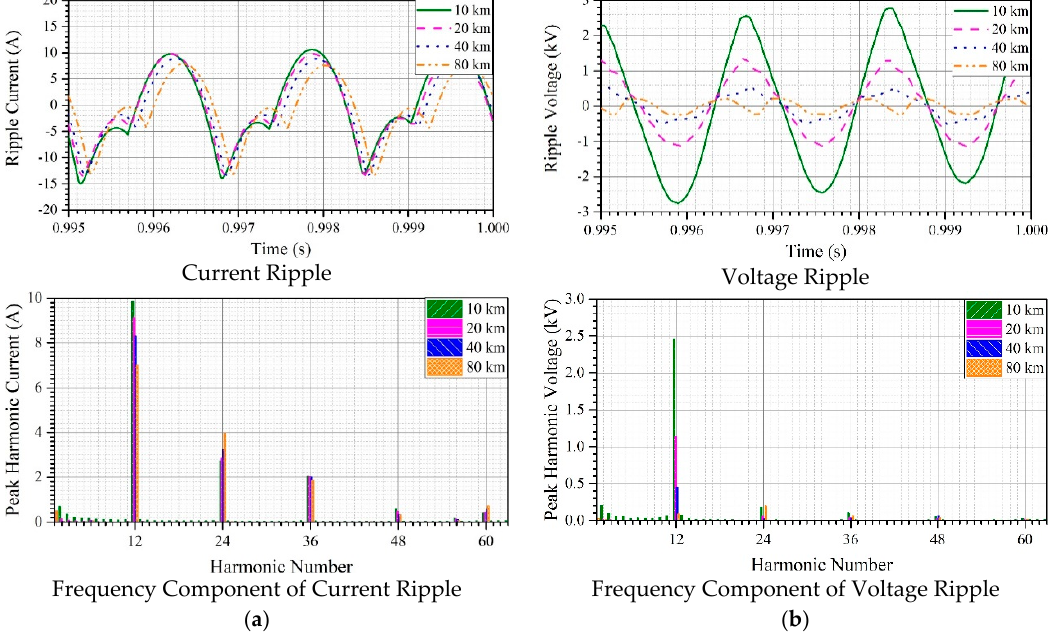
Figure 6. Ripples at sending end of the cable according to length of the cable section ( a ) Current ripple and its frequency components. ( b ) Voltage ripple and its frequency components.